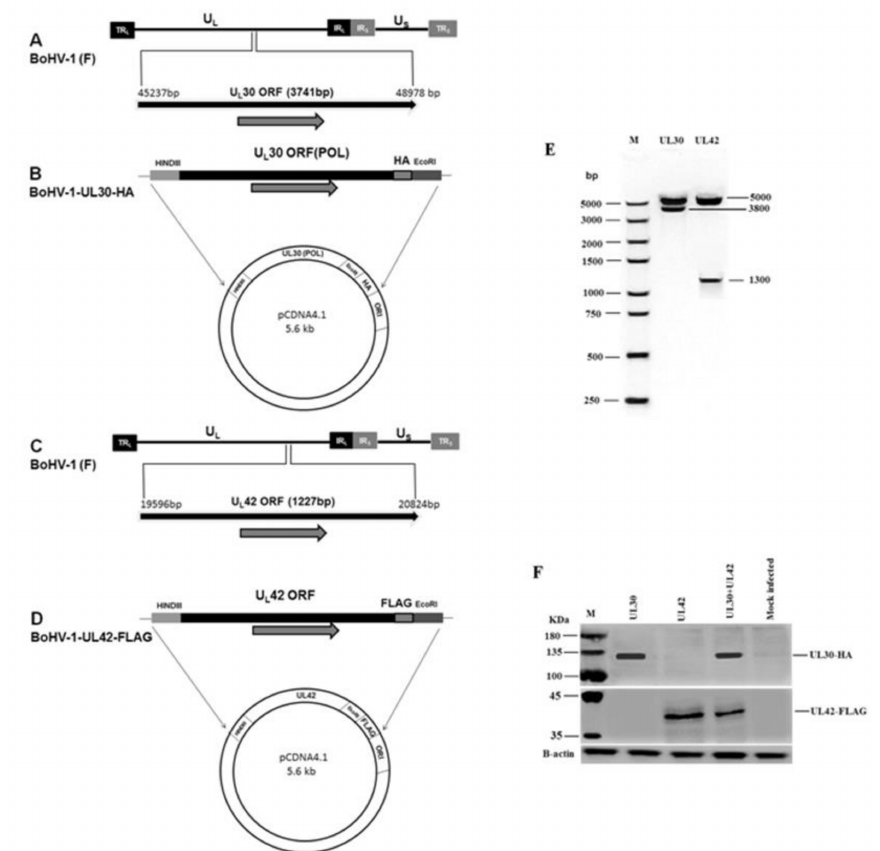
Figure 1. Construction and characterization of BoHV-1 UL30-HA and UL42-FLAG expression plasmids. ( A ) Schematic representation of the BoHV-1 genome (140 kb), along with unique short (US), unique long (UL), terminal repeat (TR), and internal repeat (IR) sequences. Position of UL30 (POL) is located between 45237 nt and 48978 nt on the BoHV-1 genome. ( B ) UL30 (POL) gene with restriction sites HindIII and EcoRI and the HA tag at C terminus was cloned into the vector pcDNA4. ( C ) Position of UL42 located between 19596 nt and 20824 nt on the BoHV-1genome. ( D ) UL42 containing restriction sites HindIII and EcoRI and the FLAG tag at C terminus were cloned into pcDNA4. ( E ) Restrictive digestion with Hind III and EcoRI. ( F ) SDS-PAGE / Western blotting assays were performed to detect the indicated fusion proteins. MDBK cells were transfected with indicated plasmids. At 24 h post transfection, the cells were processed for SDS-PAGE / Western blotting assays and the fusion proteins pUL30-HA and pUL42-FLAG were detected with monoclonal antibodies against either HA or FLAG tags. A representative blot of three independent experiments was